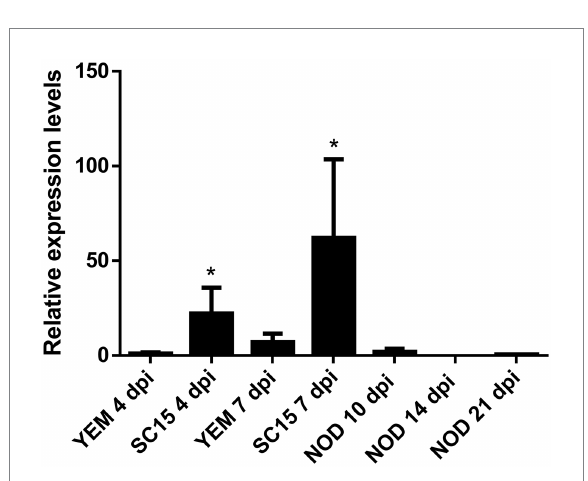
FIGURE 4 Expression of NIPK in response to rhizobia. RT-qPCR analysis showing relative expression of NIPK in roots 4 and 7 days after infection with the strain SC15 of Rhizobium etli or mock- inoculated roots (YEM) or nodules collected at 10, 14, and 21 days post-infection. Transcript levels were normalized by the levels of the reference gene EF1- α . The error bars represent the SD of three biological replicates. Asterisks indicate statistical significant differences in a t -test with p < 0.05 comparing the values of each tissue with the control YEM root at the same time